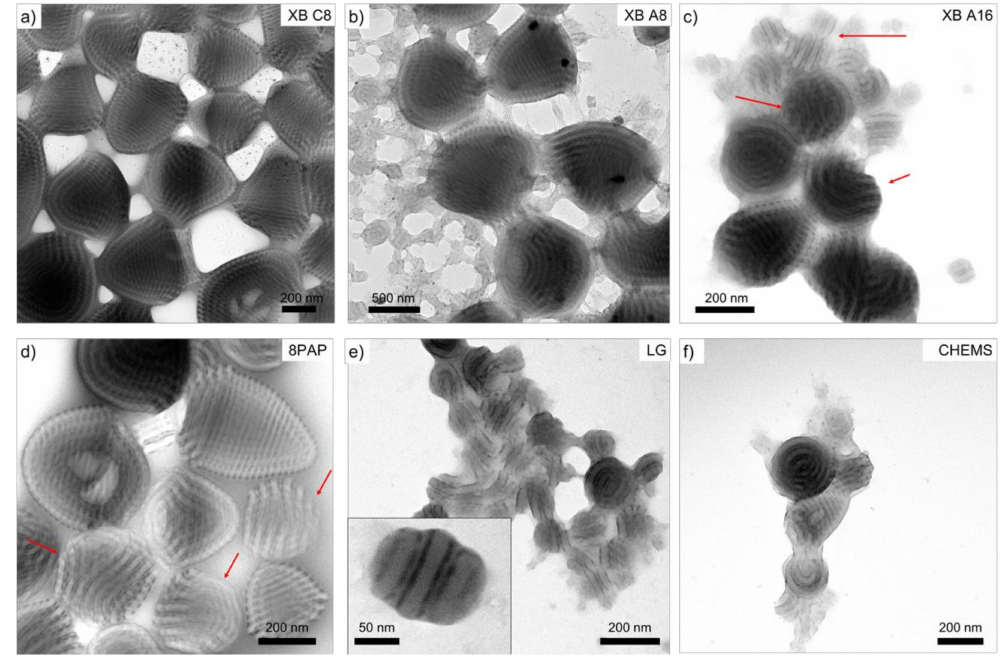
Figure 5. Microparticles of SVT2 loaded with a molar fraction of bonders, x = 1.00. TEM images of conic microparticles with lc morphology obtained for ( a ) XB C8, ( b ) XB A8, ( c ) XB A16, ( d ) 8PAP, ( e ) LG, and ( f ) CHEMS. (Color code in TEM image: PS grey, P4VP dark grey due to iodine staining; scale bars are 200